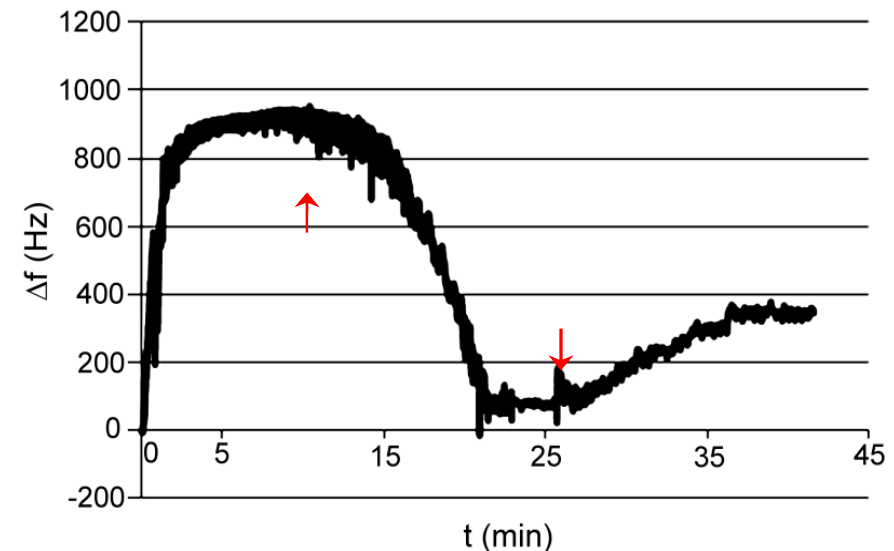
Figure 13. Changes of frequency in time for AP I polymer; absorbed compound—acetylsalicylic acid in ethanol.